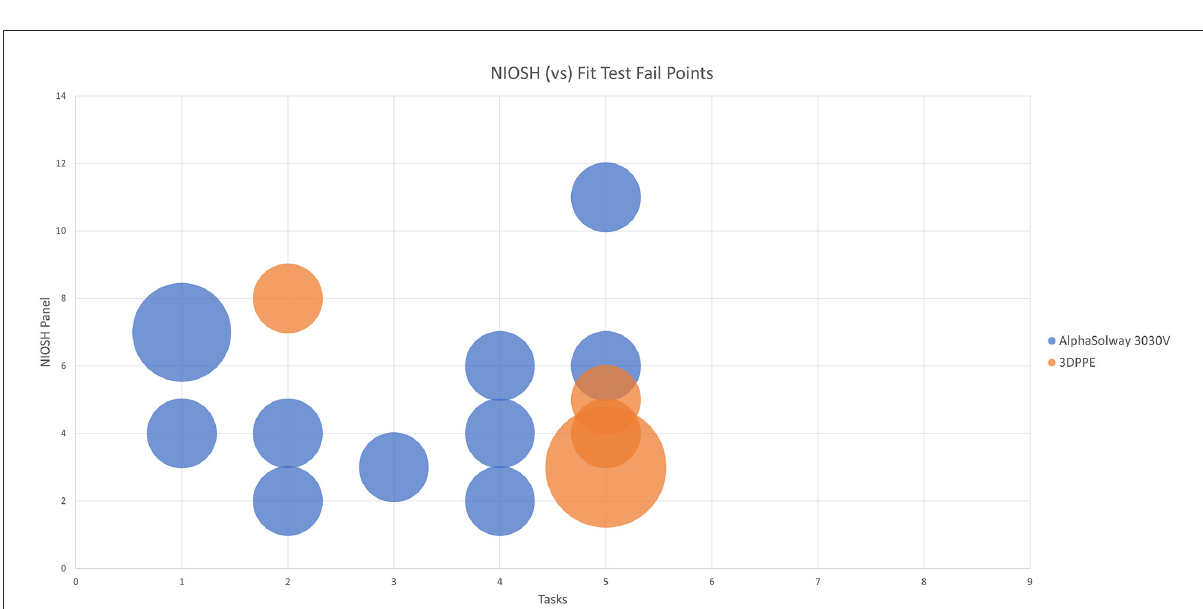
As gender discrepancies in fit testing and PPE specificity have been previously reported (8) results were stratified by sex and differences in overall R-COMFI score assessed